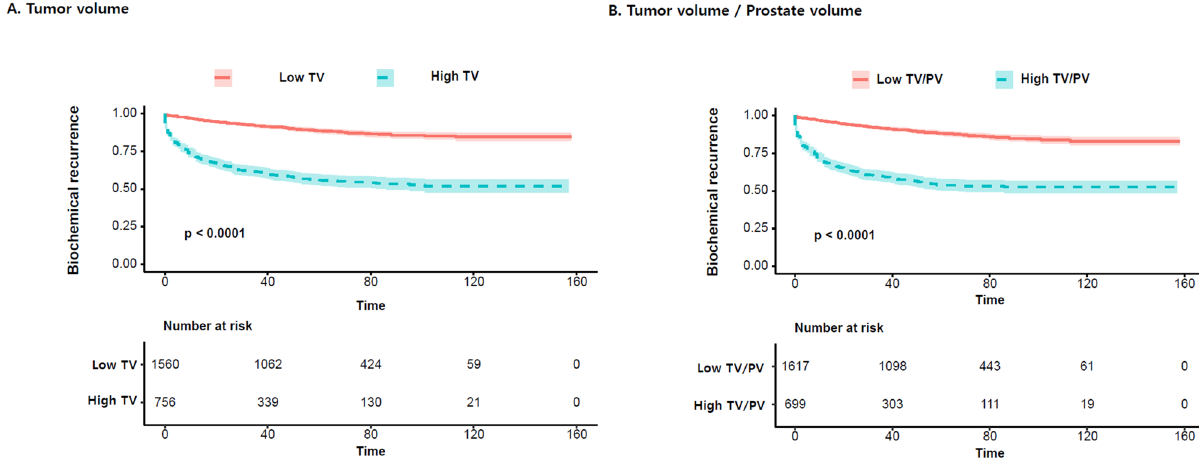
Figure 1. Kaplan–Meier analysis on the biochemical recurrence free survival according to the tumor volume.